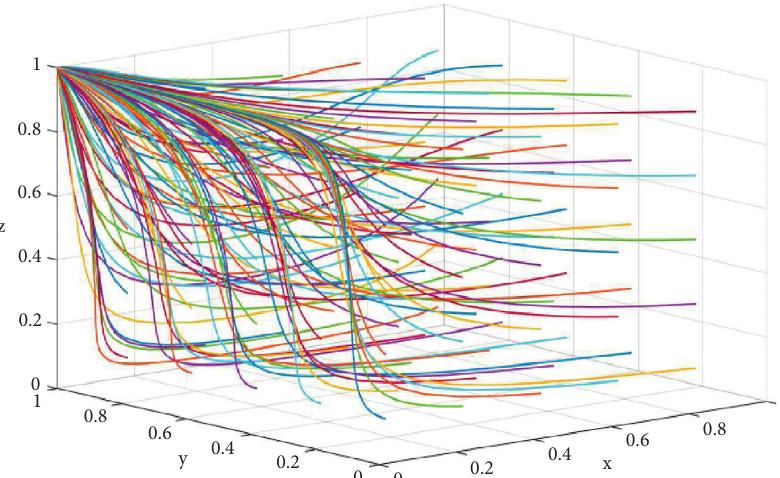
Figure 6: The simulation results of array 2.